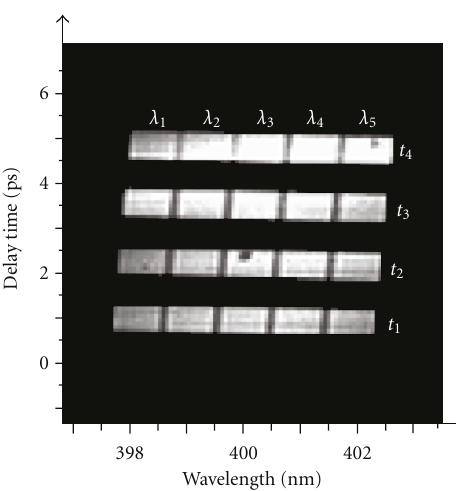
Figure 3: The spatial distribution of whole wavelength channel and time slot in fit a state for switching by MEMS optical